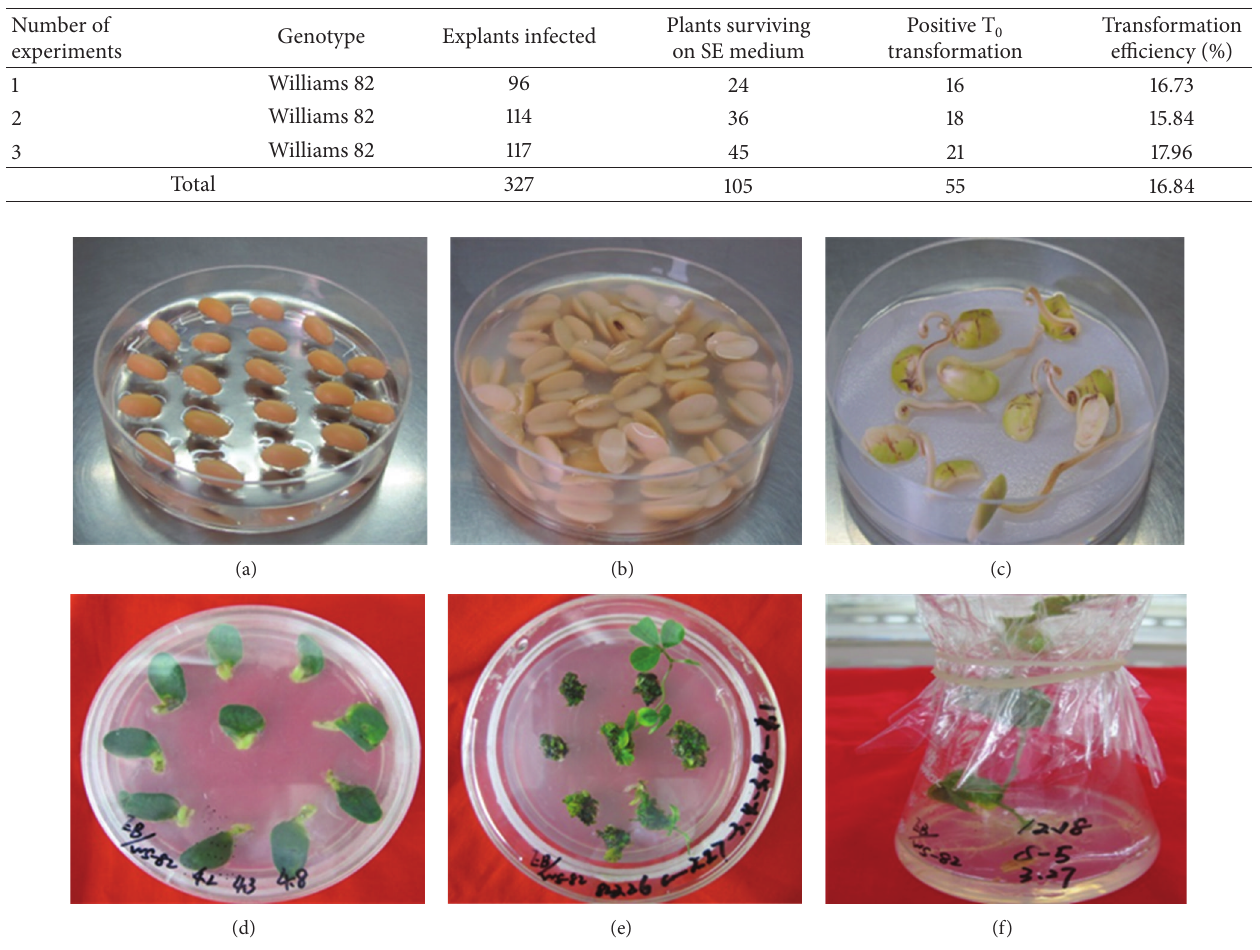
Figure1: Agrobacterium -mediatedsoybeantransformationusingthecotyledonarynodeasexplants.(a)SeedgerminationintheGMmedium for the night. (b) Inoculation of explants with Agrobacterium . (c) A longitudinal cut between the cotyledons and through the hypocotyl to generate two identical explants. (c) Explants cocultured with Agrobacterium for 5 days. (d) Two weeks after selection on shoot induction (SI) medium containing 5mg/L glufosinate. (e) Elongated shoot in shoot elongation (SE) medium. (f) Rooting of the resistant